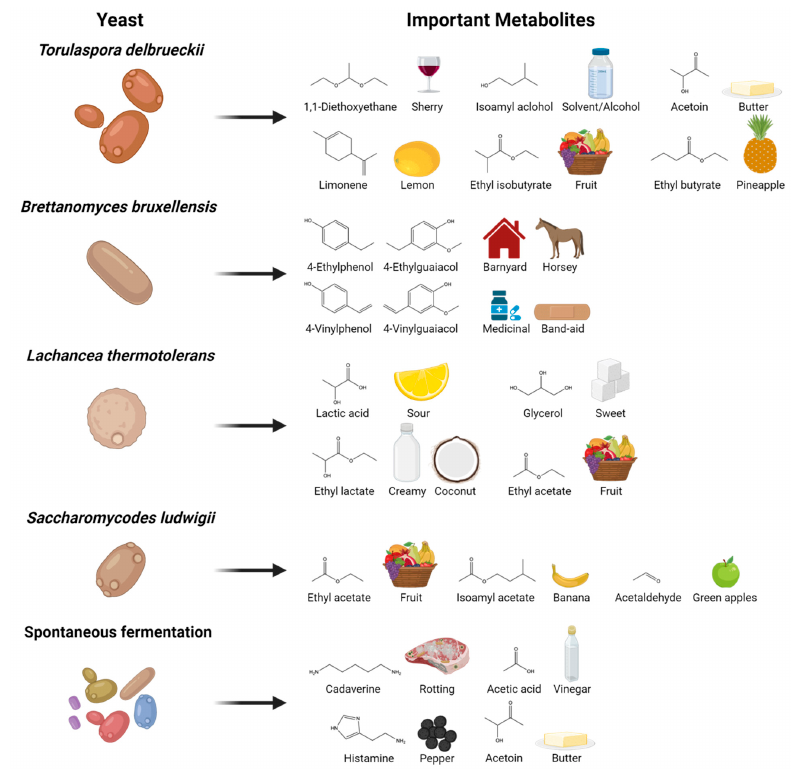
Figure 1. Common non- Saccharomyces yeasts used in beverage fermentation and their important metabolites.